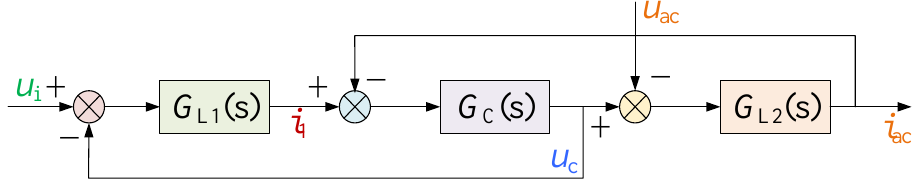
Figure 2. LCL mathematical control model block diagram.